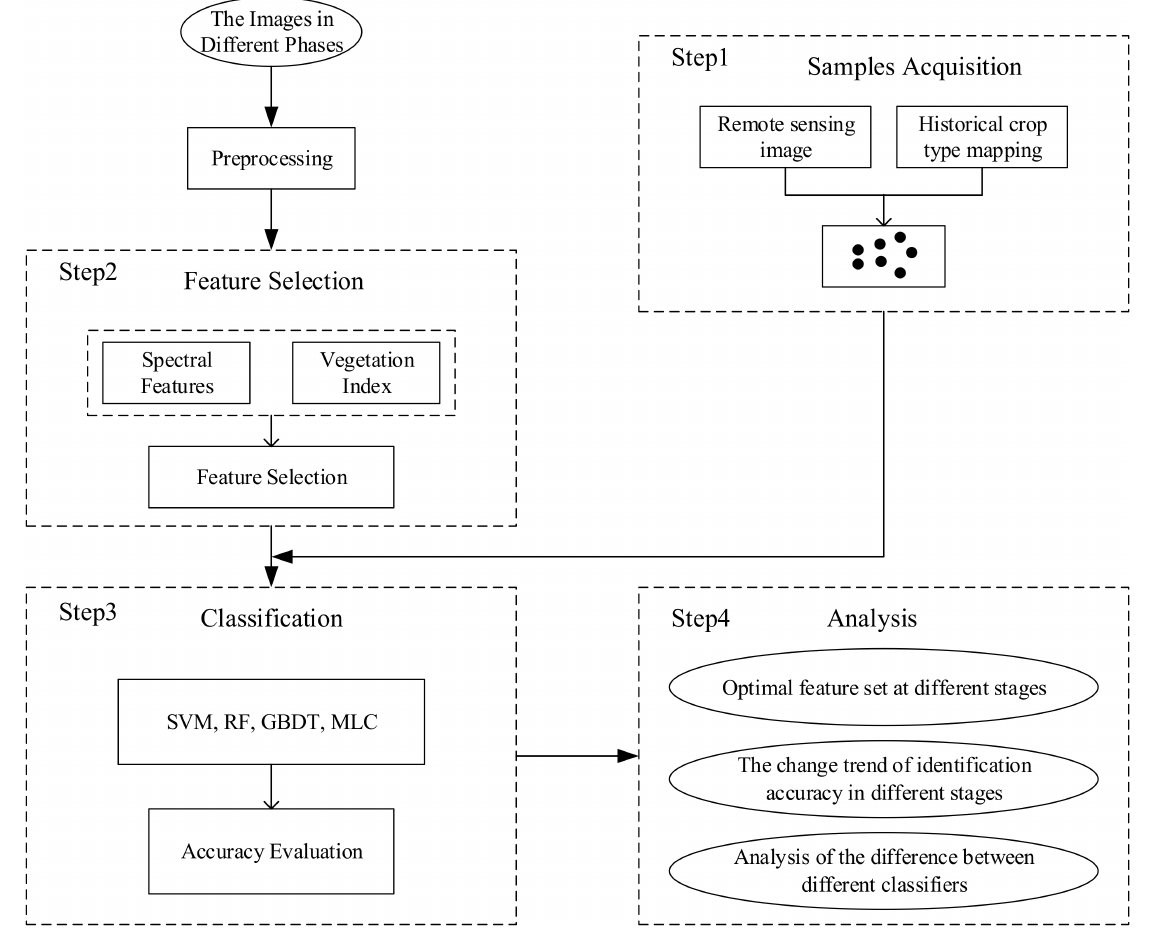
Figure 3. Illustration of early crop